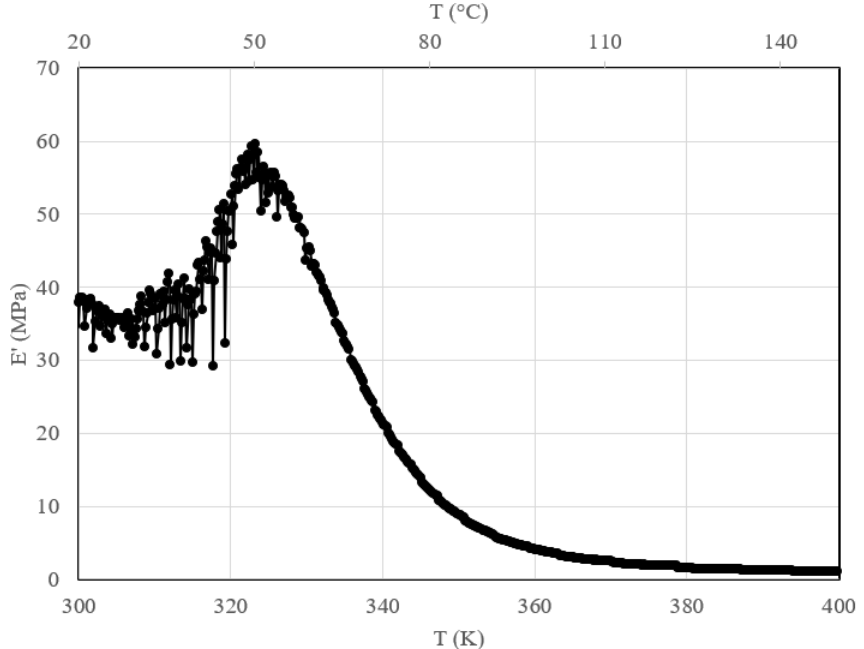
Figure 14. E’ varying as a function of temperature for a 15 sec carbonated sample.